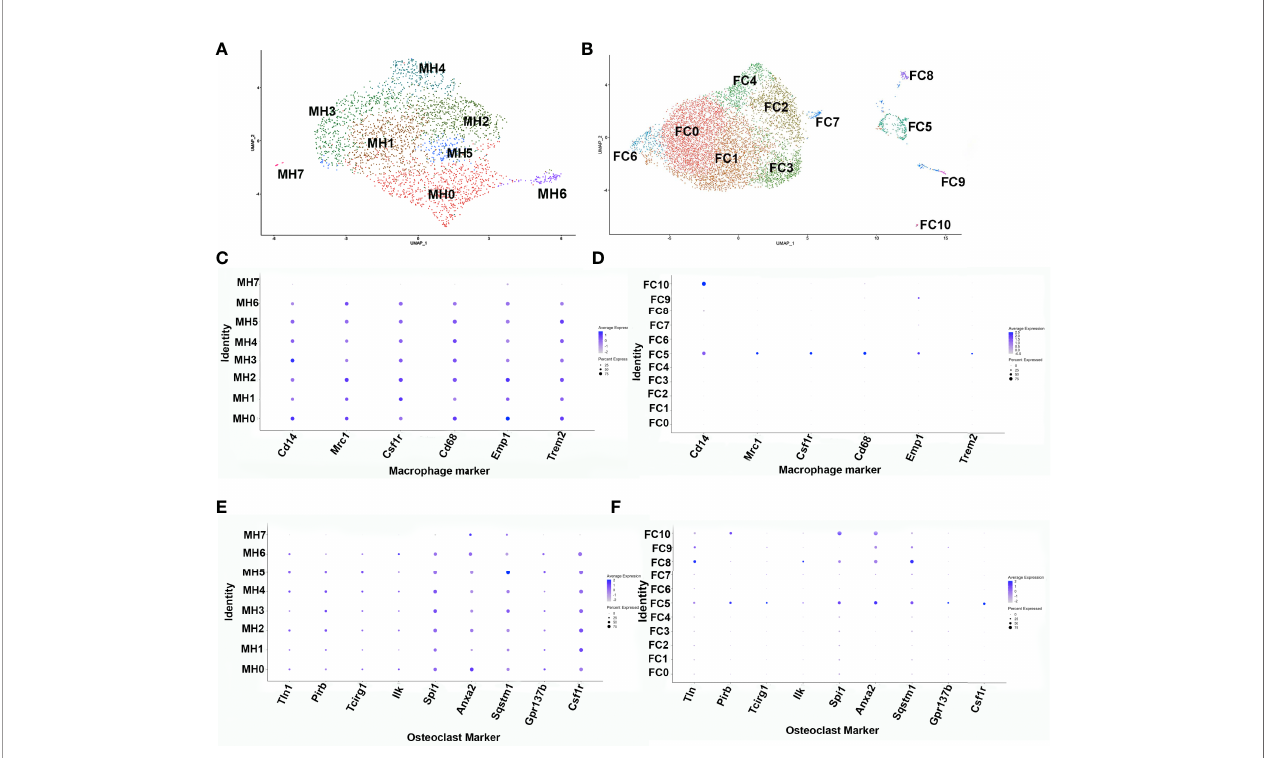
FIGURE 1 | Single-cell transcriptome analysis of ADR b 3+ cells isolated from regions of active bone formation. Analysis of single-cell RNAseq transcriptomes using the Seurat (v3) algorithm. This analysis was done several times with similar results. Transcriptomes associated with the ADR b 3+ cells isolated from (A) HO and (B) fracture callus. DotPlots of macrophage transcript expression using the Seurat algorithm in (C) HO and (D) fracture callus. DotPlot depiction of osteoclast- associated transcript expression in (E) HO and (F) fracture